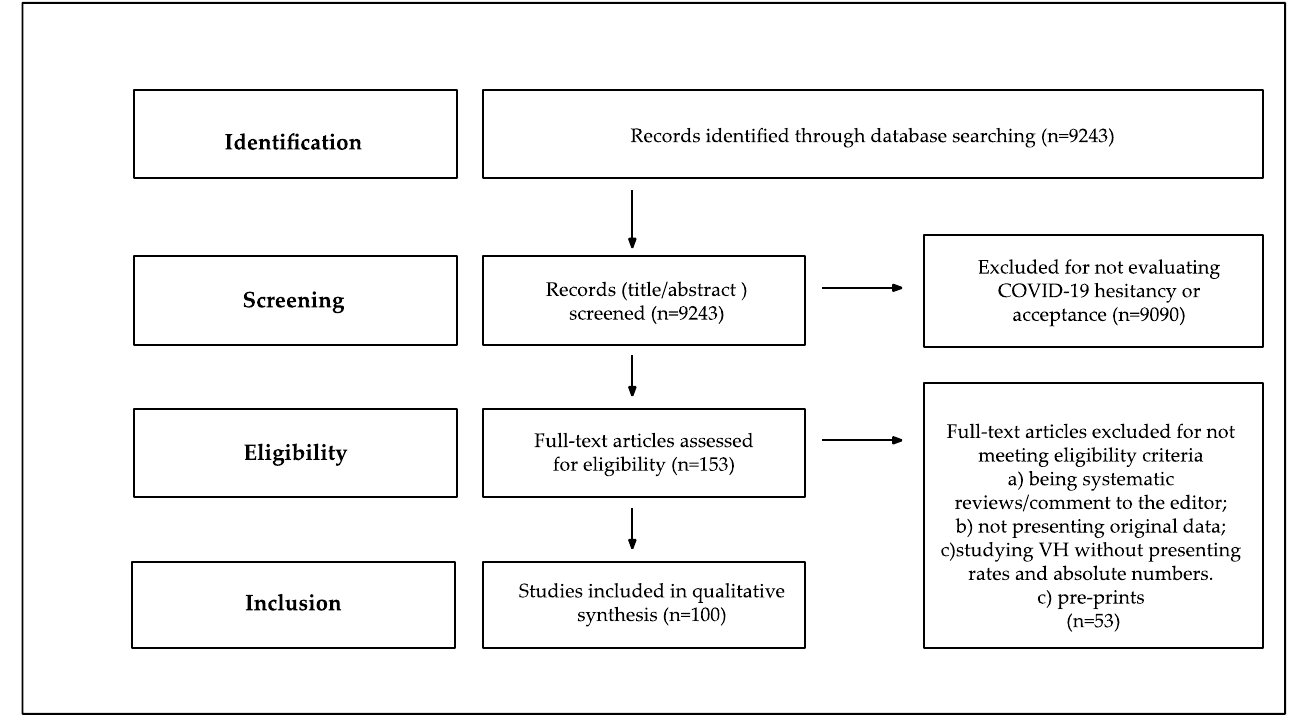
Figure 1. Flow chart of the study selection process. Table 1. COVID-19 confidence rates by included studies and sorted according to WHO global regional area definitions between November 2019 and March